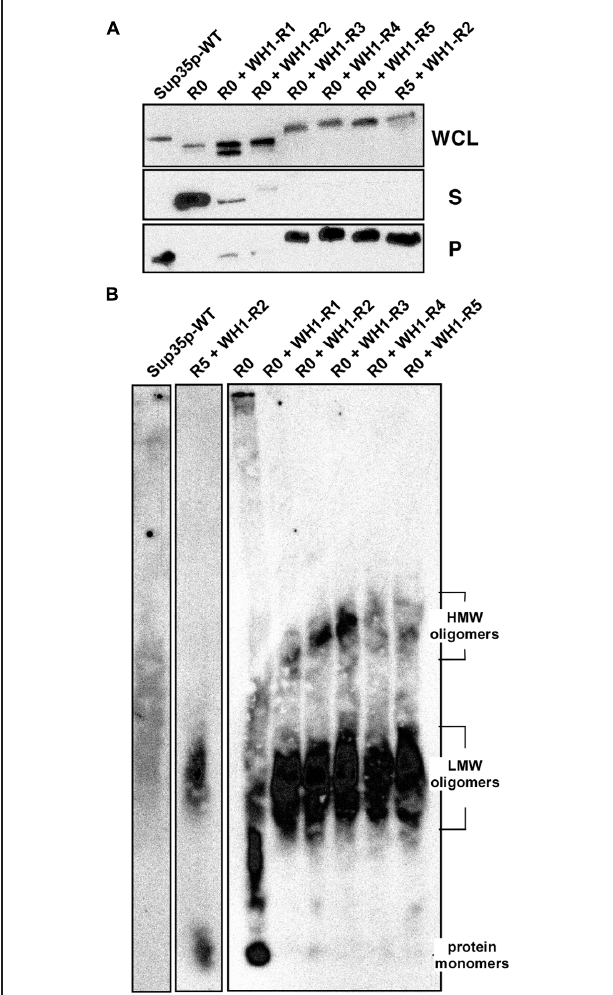
FIGURE 4 | [ REP-PSI + ] prions assemble amyloid oligomers larger than [ PSI + ]. (A) The soluble (S) and the aggregated (P) protein fractions in whole cellular lysates (WCL) from yeast overproducing the indicated constructs were separated by ultracentrifugation. Sup35p and the R5 + WH1-R2 and R0 + WH1-R3-5 chimeras preferentially aggregate. (B) In extracts from cells expressing the chimeras, SDD-AGE resolves two populations of detergent-resistant amyloid aggregates, with distinct average molecular weights (Low-MW and